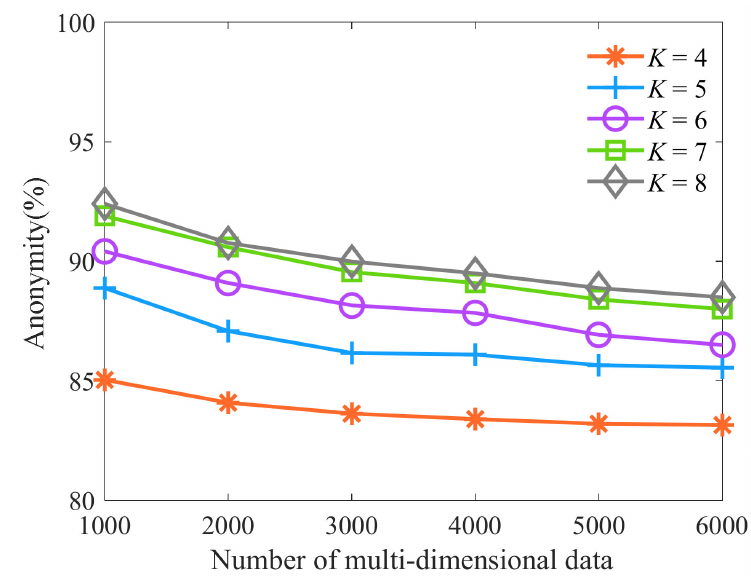
Figure 3. Algorithm anonymity of different clustering number K